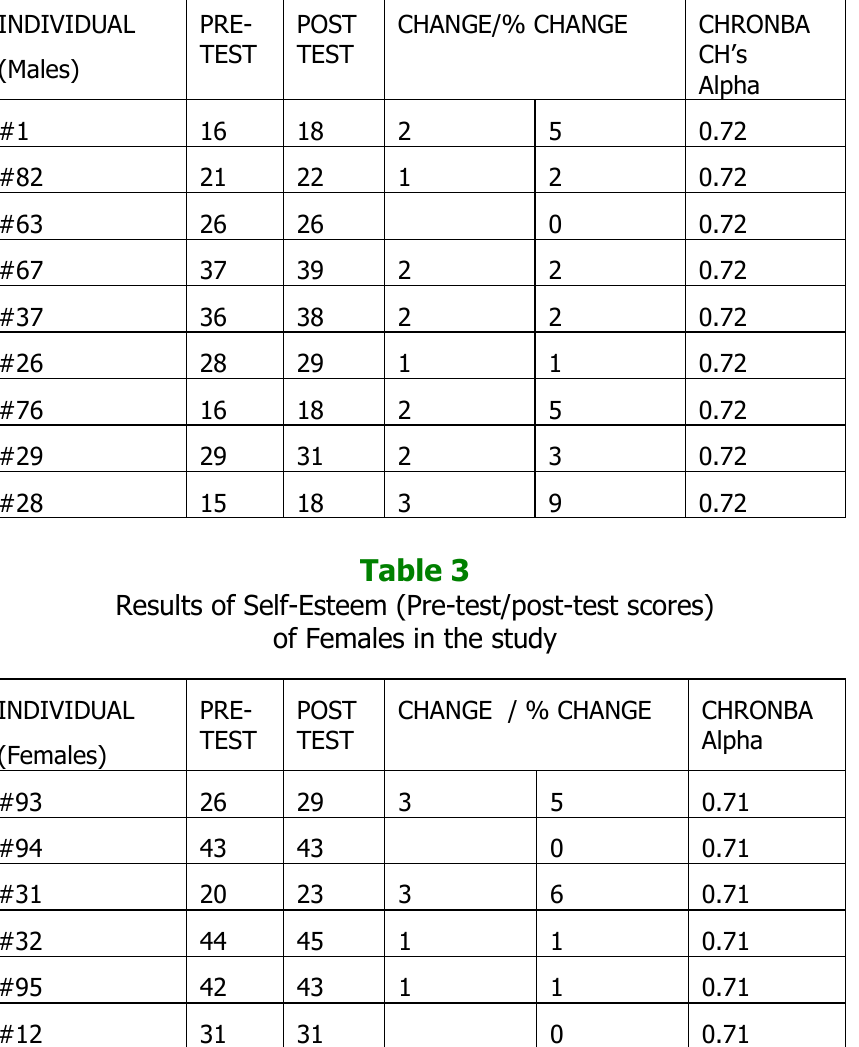
Results of Self-Esteem (Pre-test/post-test scores) of Males in the study